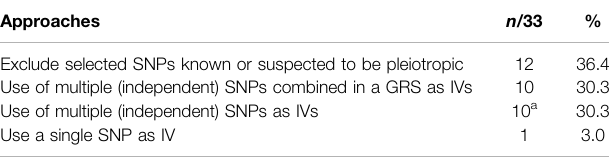
TABLE 2 | Approaches cited for preventing pleiotropy in the selection of IVs. Approaches n